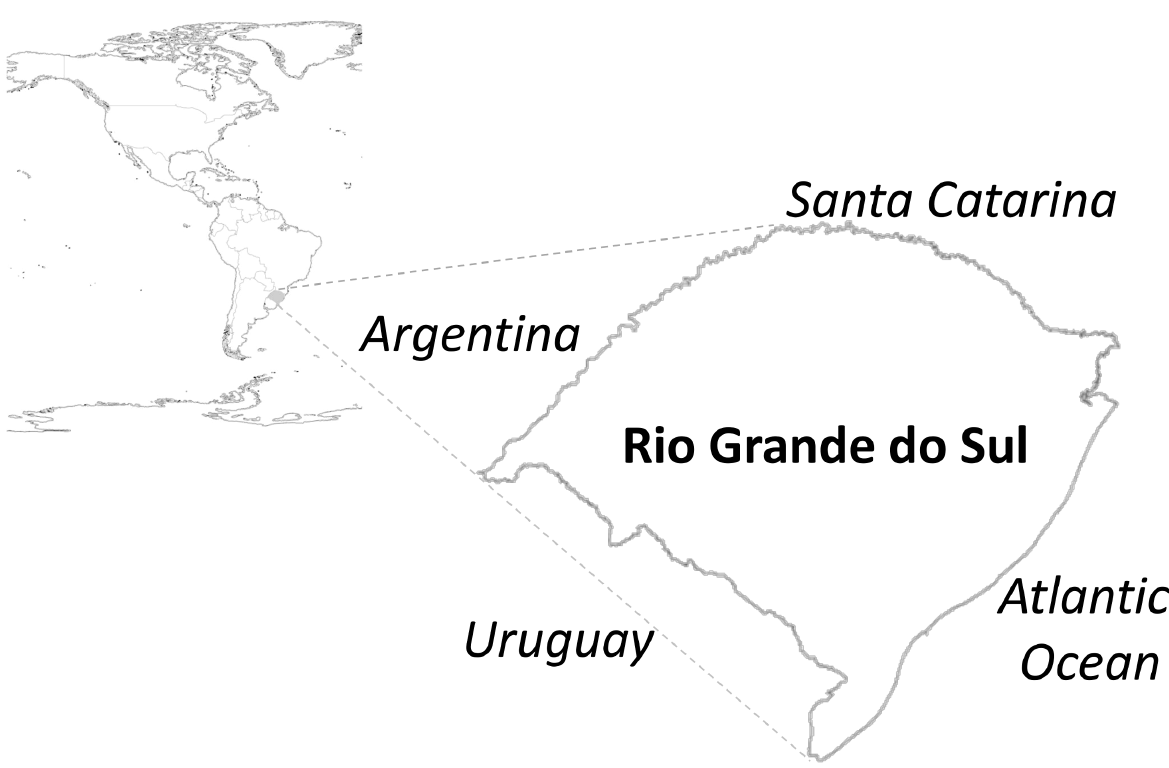
Figure 1. Map showing the state of Rio Grande do Sul, Brazil. The Brazilian state of Santa Catarina lies to the north, Uruguay to the south, Argentina to the west and the Atlantic Ocean to the east.